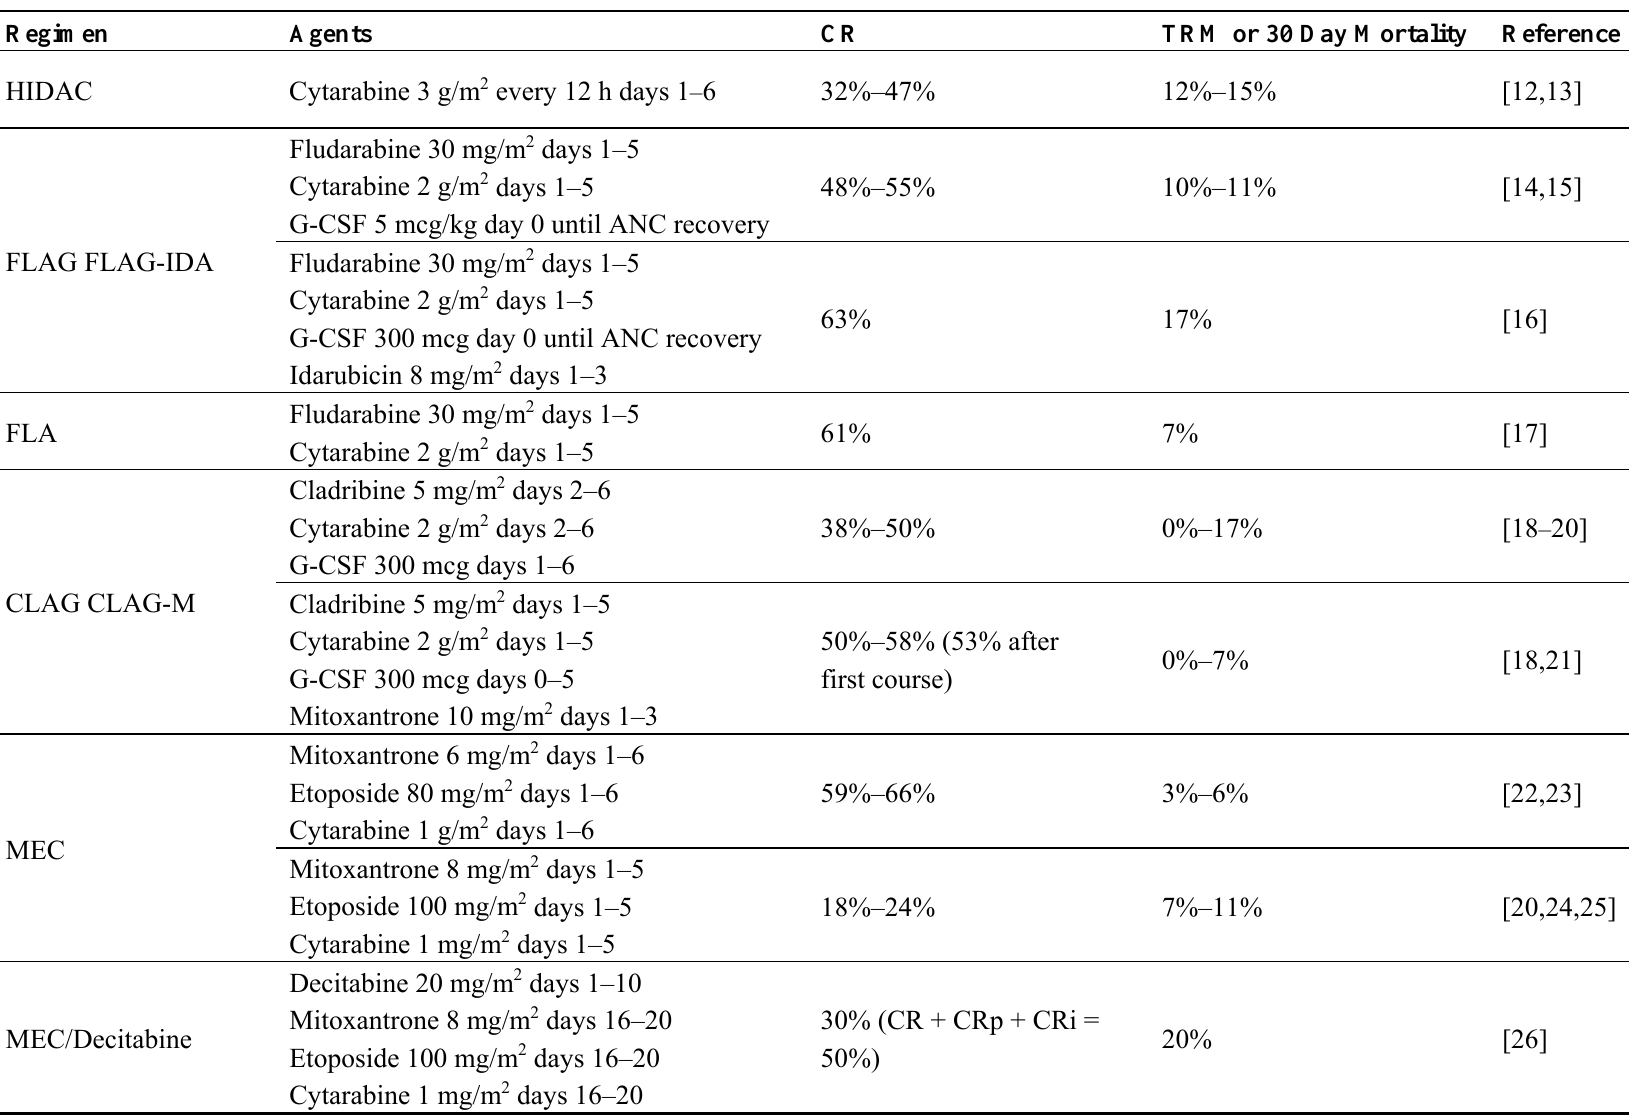
Table 1. Conventional and novel cytotoxic salvage chemotherapy regimens utilized in patients with relapsed/refractory acute myeloid leukemia